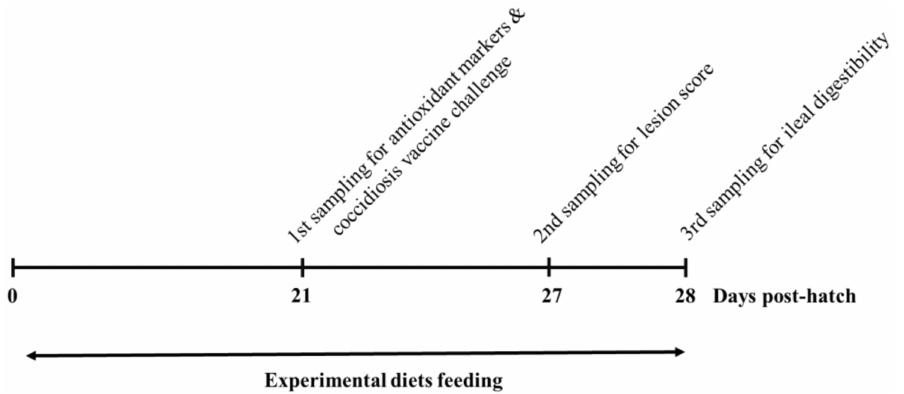
Figure 1. Schematic outline of the experimental design. Chickens were fed diets containing none, methyl sulfonyl methane, or sodium sulfate until the end of the experiment. Blood, liver, and intestine samples were obtained at 21 days, and all chickens except for the non-challenged control groups were orally challenged with coccidiosis vaccine at 21 days. Intestinal samples were obtained for scoring gut lesions at 27 days (i.e., 6 days of post vaccine challenge). At 28 days, ileal digesta were sampled for assessing ileal nutrient digestibility.